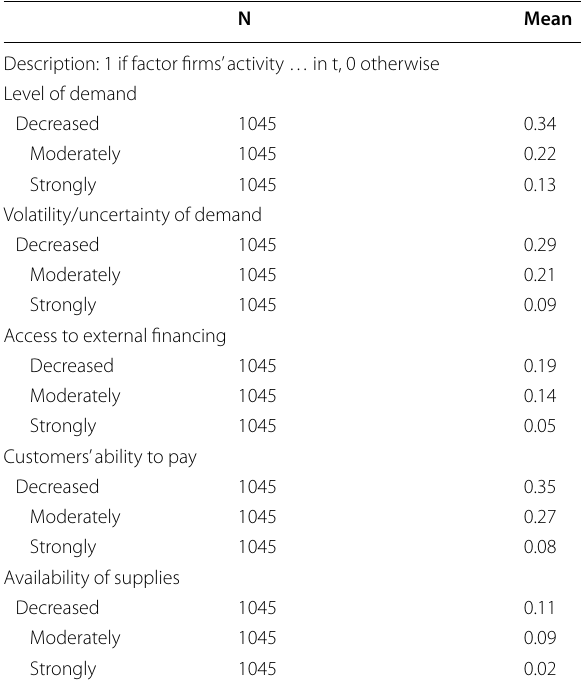
Table 7 Variables definition and summary statistics